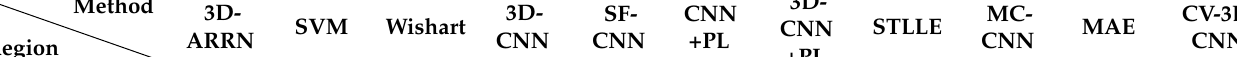
Table 7. The classification accuracy (%) of various methods on the Flevoland I